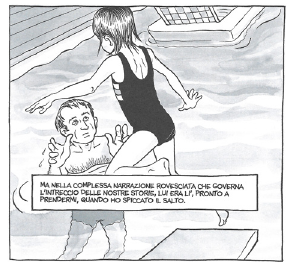
Fig. 8 The final strip of Fun